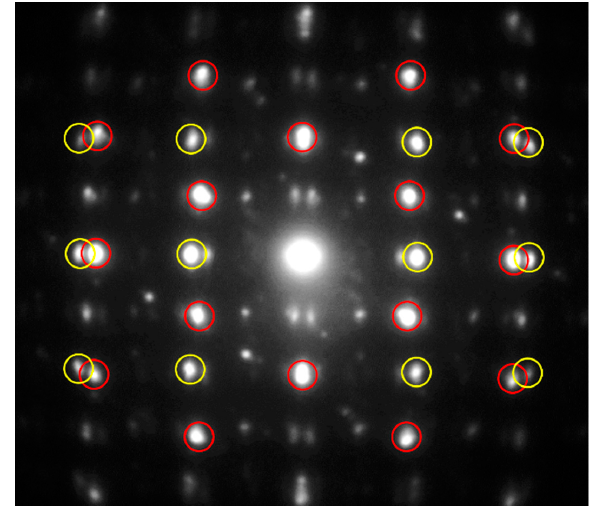
Figure 11. Selected area electron diffraction pattern down (001) of merelaniite. Red and yellow circles refer to the H and Q pseudo-layers, respectively. (Sample 3666qx A grid A2.).